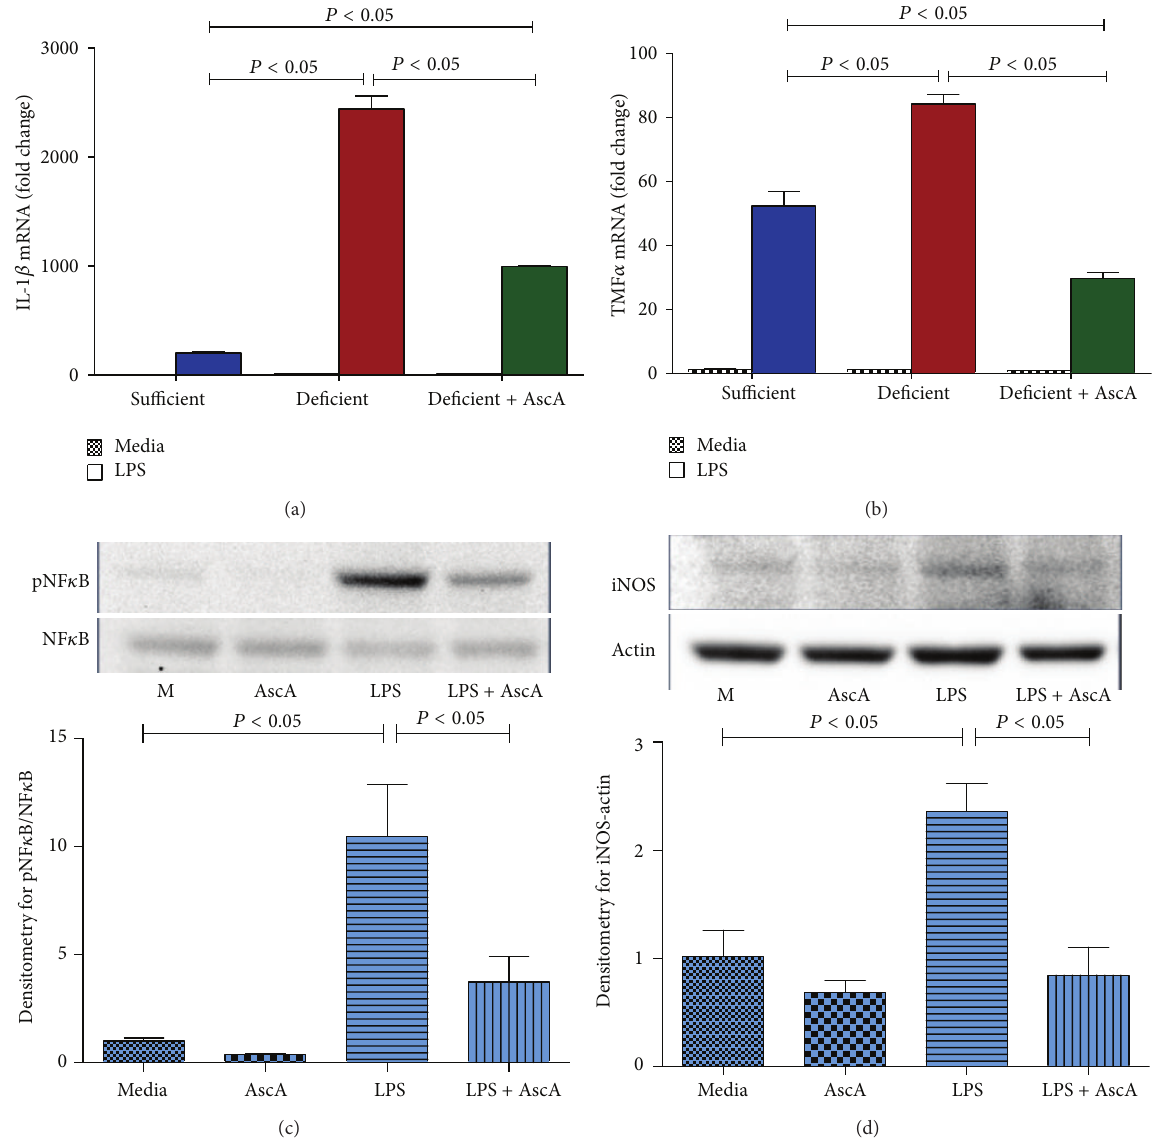
Figure 3: LPS differentially activates proinflammatory gene expression in macrophages from vitamin C sufficient and deficient mice. Peritoneal macrophages elicited on day 3 following TG-induced peritonitis from VitC sufficient and deficient Gulo −/− mice were exposed to LPS (50 ng/mL) for 4 hours. Macrophages from some VitC deficient mice were incubated with AscA (3 mM, 16 hours) prior to LPS exposure (deficient + AscA). Real time QPCR was performed for IL-1 𝛽 (a) and TNF 𝛼 (b) ( 𝑁 = 6 /group). (c) Upper panel: representative western blot for expression of phospho-NF 𝜅 B and NF 𝜅 B from VitC deficient macrophages exposed to media alone (M), AscA (3mM, 16 hours (AscA)), LPS (50ng/mL) for 1 hour (LPS), or AscA for 16 hours followed by LPS for 1 hour (LPS + AscA). Lower panel: densitometry for normalized expression of phospho-NF 𝜅 B from macrophages ( 𝑁 = 3 /group). (d) Upper panel: representative western blot for expression of iNOS and actin from macrophages groups described in (c) and exposure to LPS (50ng/mL) for 4 hour. Lower panel: densitometry for normalized expression of iNOS from macrophages ( 𝑁 = 3